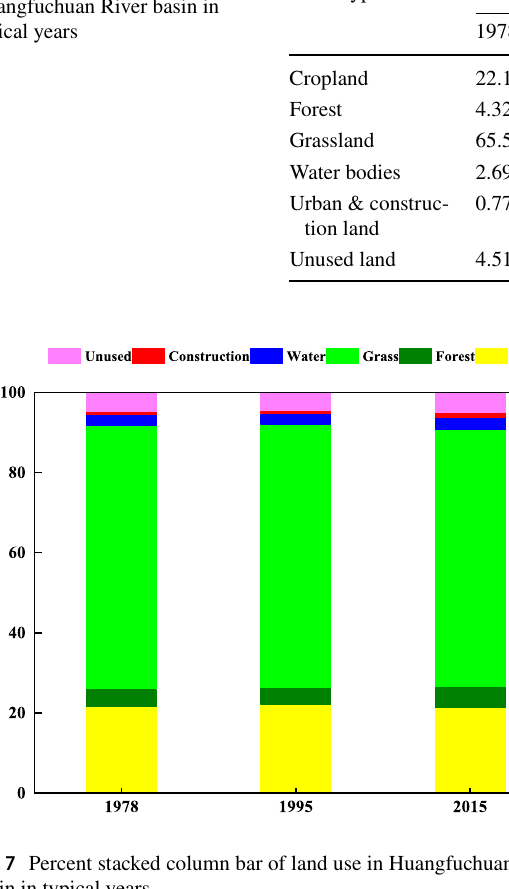
Huangfuchuan River basin in typical years